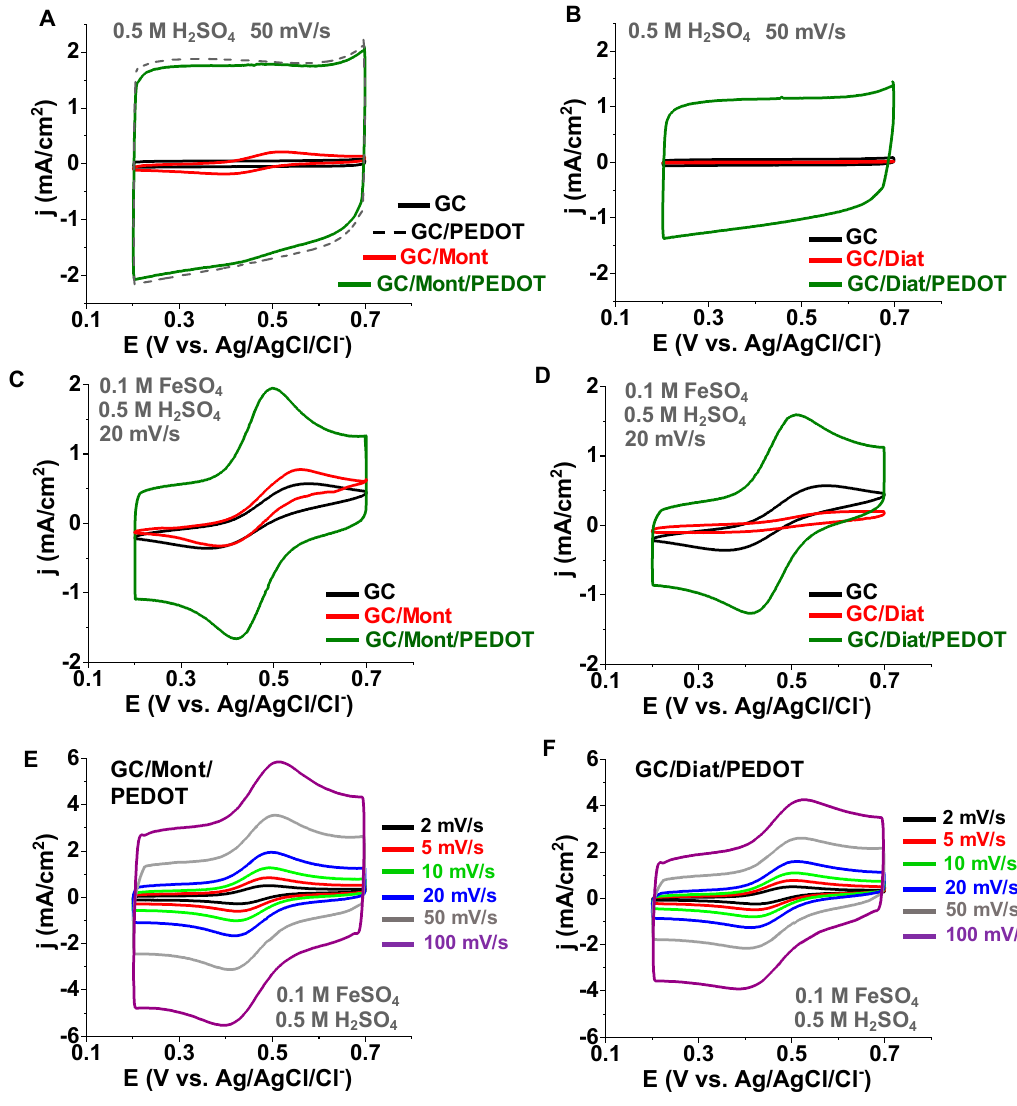
Figure 7. Steady-state cyclic voltammograms of the GC / Mont / PEDOT-PSS ( A,C ) and GC / Diat / PEDOT-PSS ( B,D ) hybrid materials in 0.5 M H 2 SO 4 aqueous electrolyte and in the absence ( A,B ) or presence of Fe 2 + / Fe 3 + probe (0.01 M FeSO 4 ) ( C,D ); v = 20 mV / s. ( E,F ) E ff ect of scan rate on the voltammetric response of GC / Mont / PEDOT-PSS ( E ) and GC / Diat / PEDOT-PSS ( F ) in the presence of Fe 2 + / Fe 3 + probe (0.01 M FeSO 4